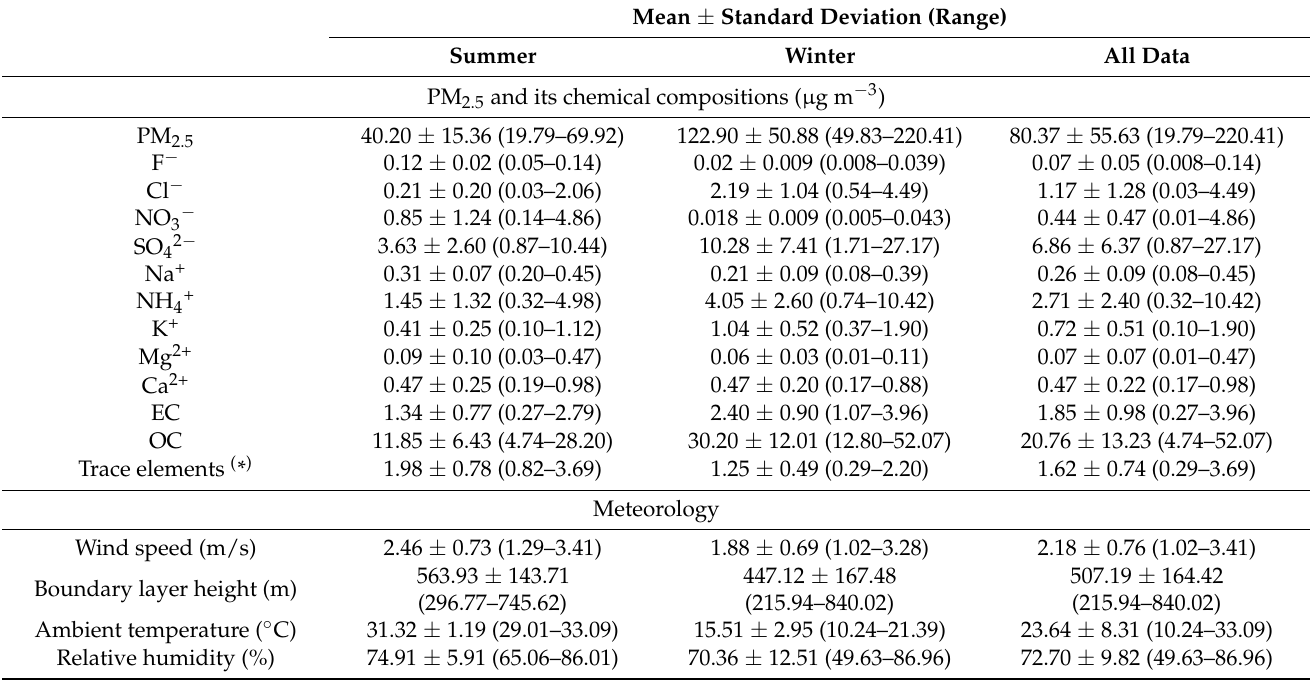
Table 1. Statistical summary of daily PM 2.5 measurement and meteorological conditions.